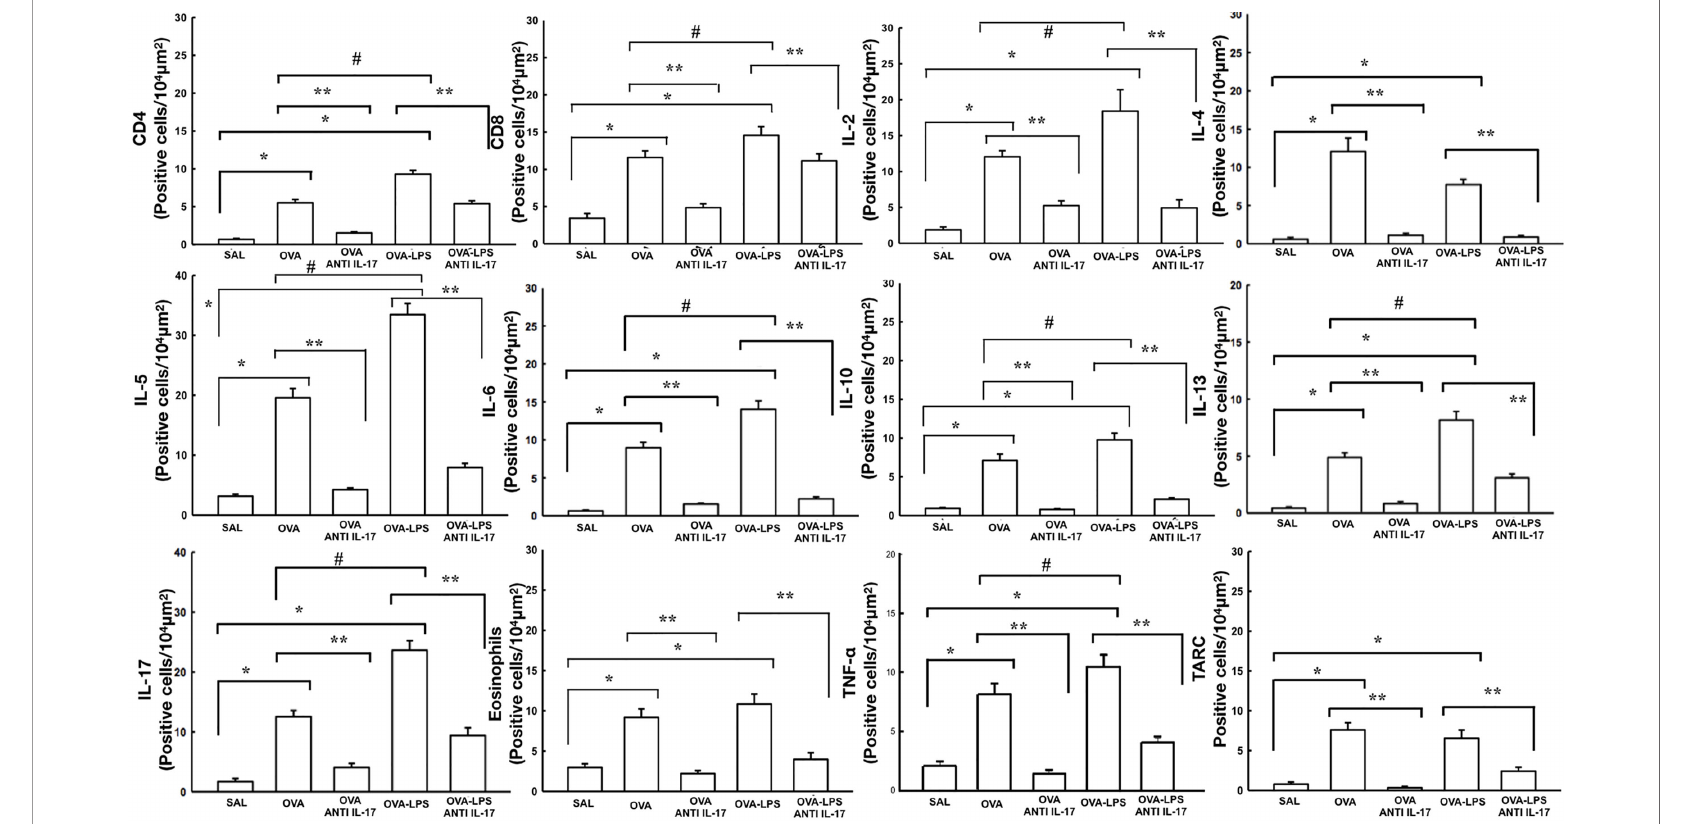
FIGURE 7 | Effects of anti-IL 17 treatment on vascular in fl ammation. The values represent the mean ± SE of CD4, CD8, IL-2, IL-4, IL-5, IL-6, IL-10, IL-13, IL-17, eosinophils, TNF- a , and TARC for all experimental groups. The differences were considered signi fi cant when p<0.05. *p<0.05 vs. SAL group; **p<0.05 vs. OVA and OVA – LPS groups. # p<0.05 vs. OVA group.